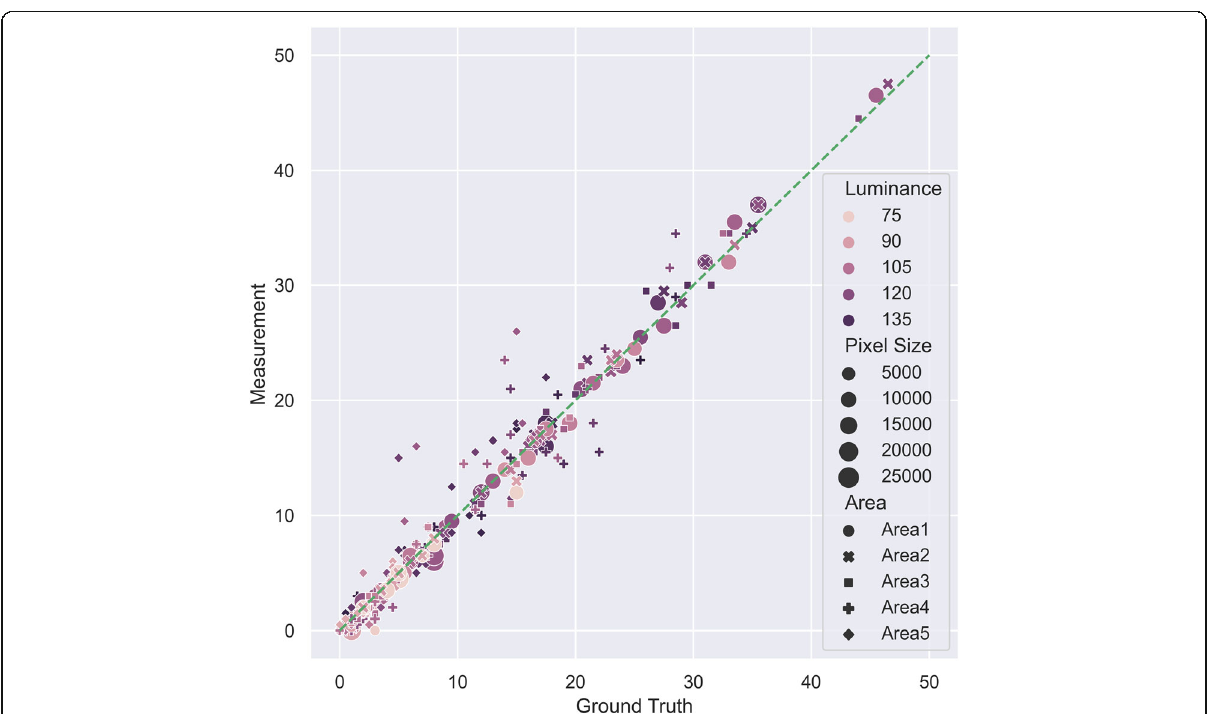
Fig. 7 Traffic count precision analysis. Each data point represents the ground truth (X-axis) and measurement (Y-axis) of one sample (60 samples for 5 study areas in total). The icon sizes indicate the pixel sizes. Darker (lighter) icons mean higher (lower)